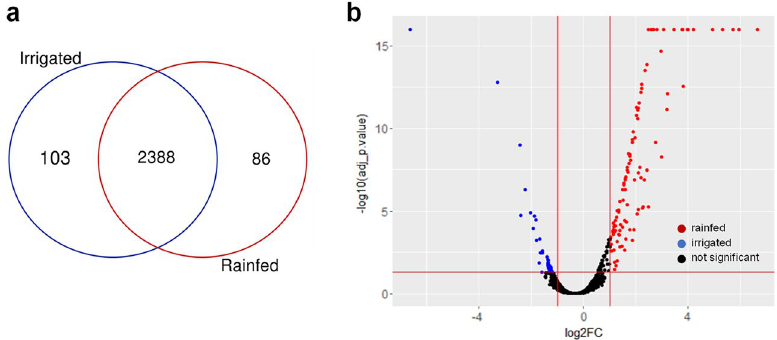
Figure 1. Total proteins quantified in quinoa seeds harvested from irrigated and rainfed conditions. ( a ) From the 2577 identified proteins in quinoa seeds, 103 appeared, exclusively in seeds harvested from irrigated conditions and 86 appeared exclusively in seeds harvested from rainfed conditions. ( b ) Volcano plot representing all the identified proteins in seeds harvested from irrigated and rainfed conditions. Different colours show two-fold differentially abundant proteins for each condition (| log 2 FC ≥ 1 |, p-adj ≤ 0.05 ; n = 3). Red dots: rainfed conditions; blue dots: irrigated conditions; black dots: no statistically significant accumulated